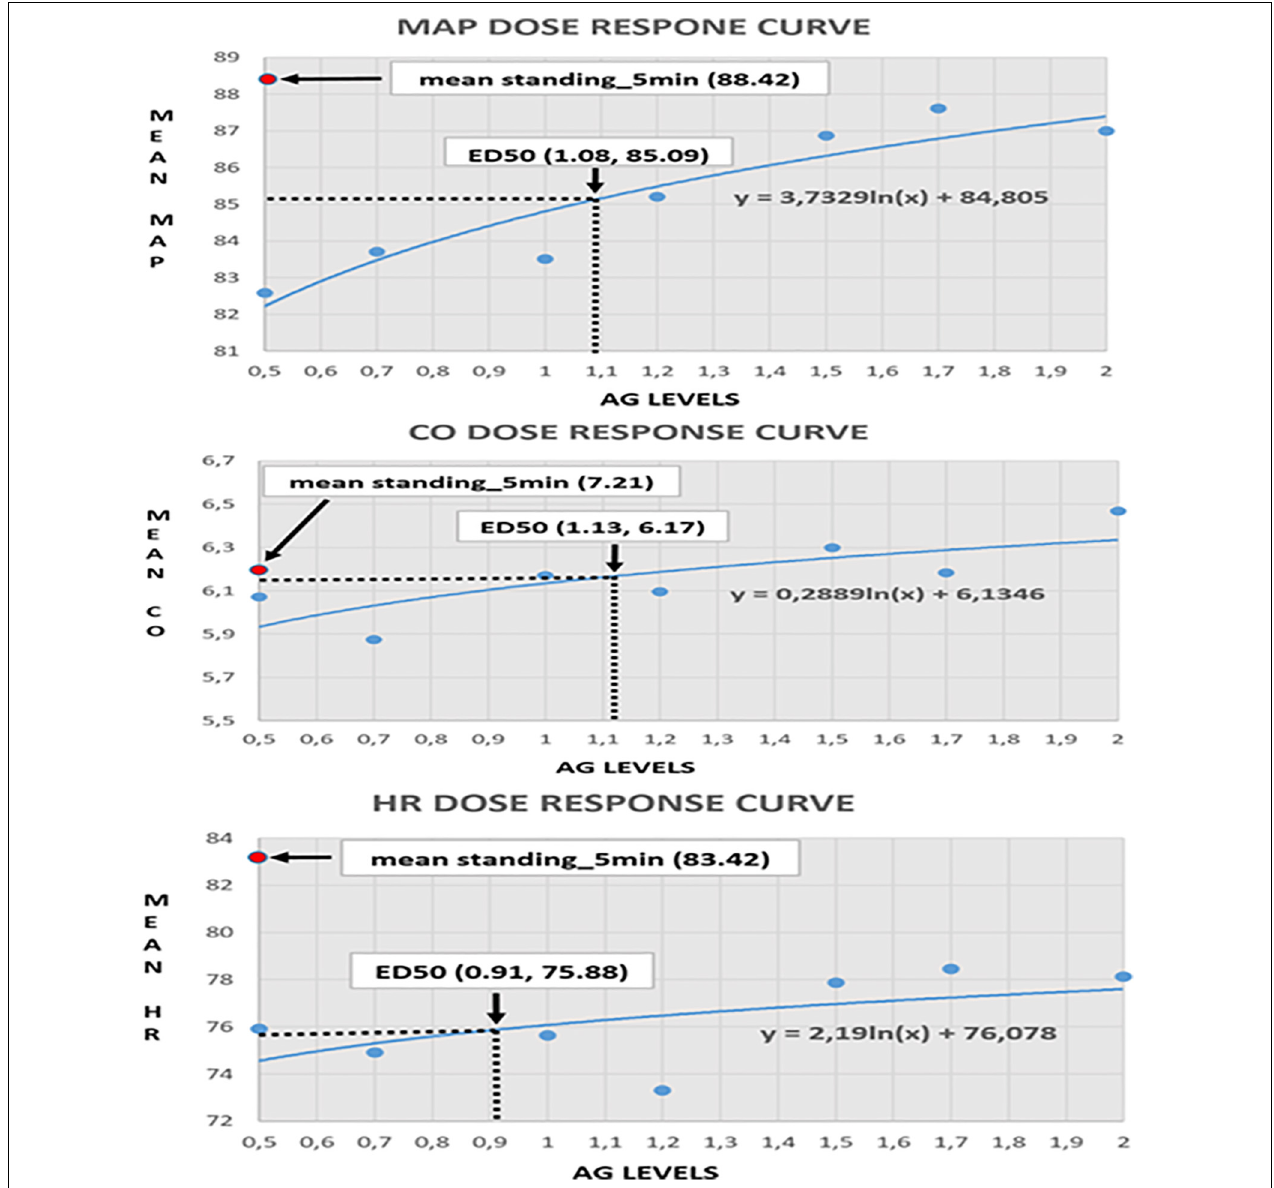
FIGURE 9 | Visualization of the dose-response curves for mean aretrial pressure (MAP), cardiac output (CO), and heart rate (HR) in seven AG loads (0.5, 0.7, 1, 1.2, 1.5, 1.7, and 2g). The MAP-ED50 is about 1.08g, corresponding to a mean MAP of 85.09. The CO-ED50 is about 1.13g, corresponding to a mean CO of 6.17. The HR_ED50 is about 0.91g, corresponding to a mean HR of